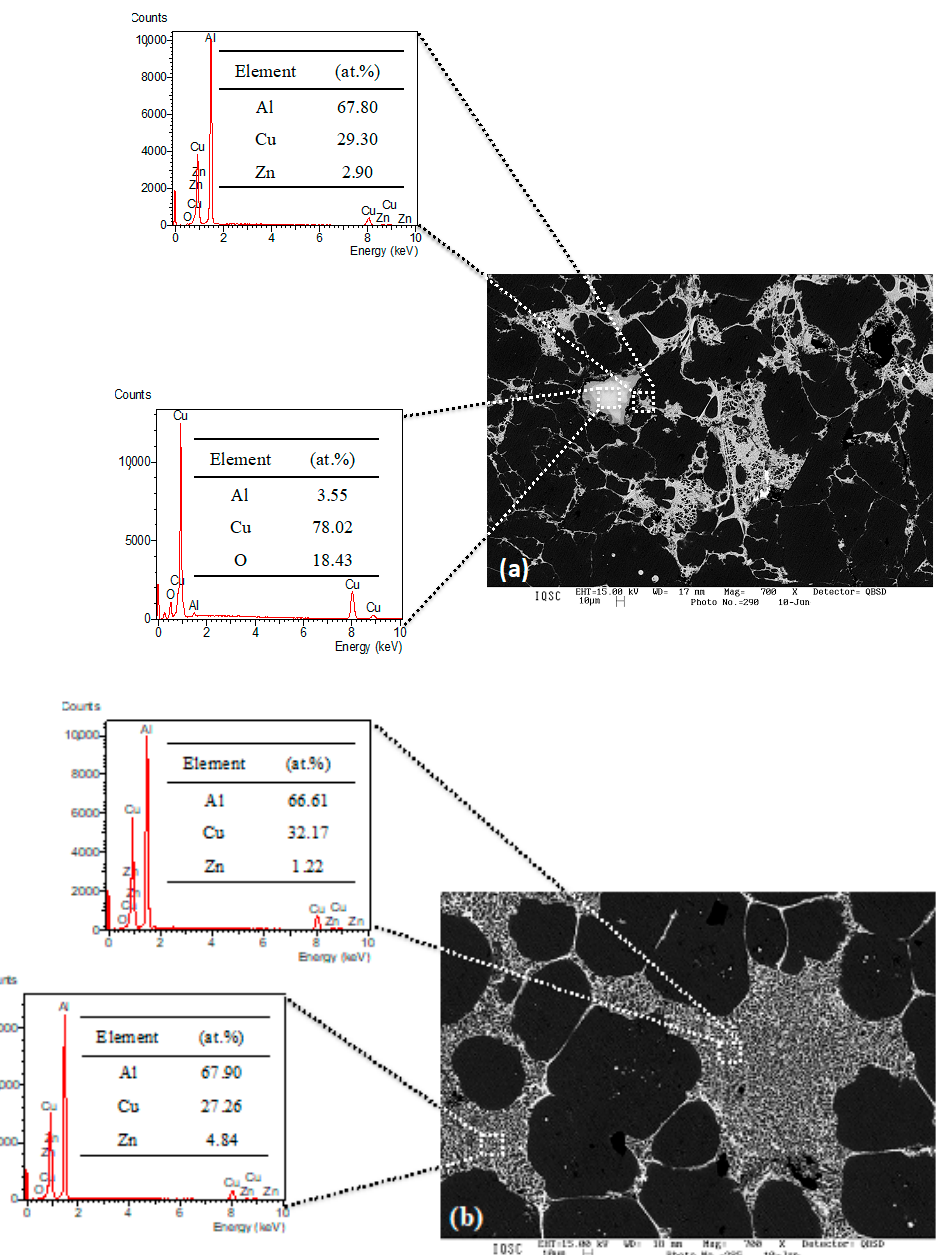
Figure 7. Typical SEM and EDX results of the Al6Cu5Zn alloy at: ( a ) 585 °C for 3 h, revealing distinct Al 2 Cu and Cu-rich regions, respectively; and ( b ) 615 °C for 3 h also evidenced a substantial region rich in Al 2 Cu (~65 and 70 wt % Al and ~24 and 28 wt % Cu